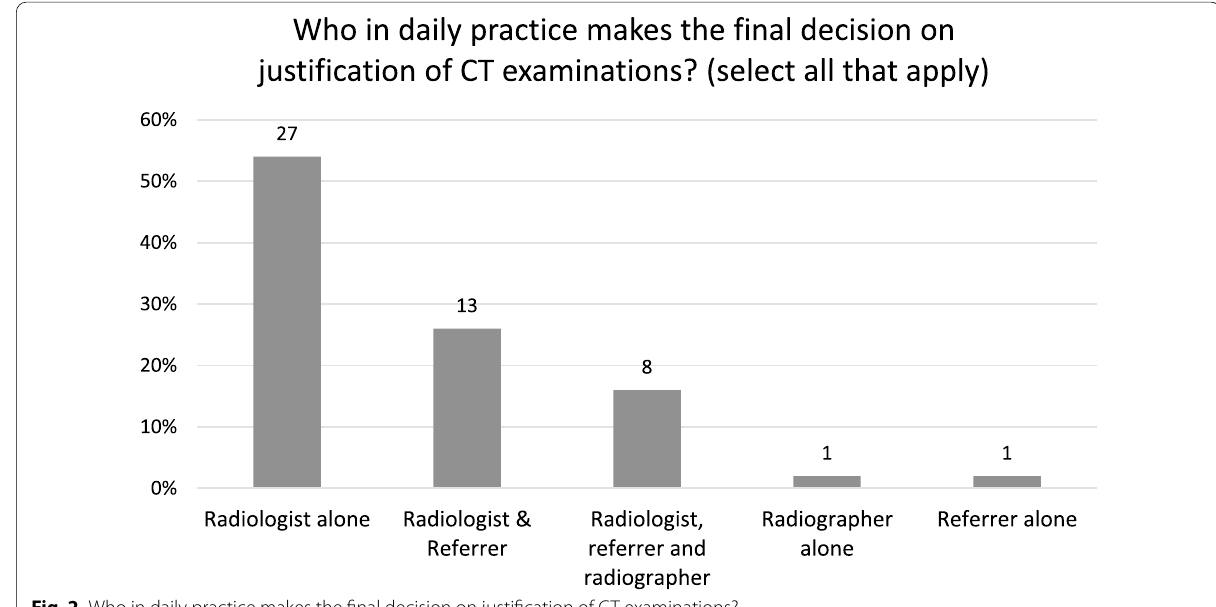
Fig. 2 Who in daily practice makes the final decision on justification of CT